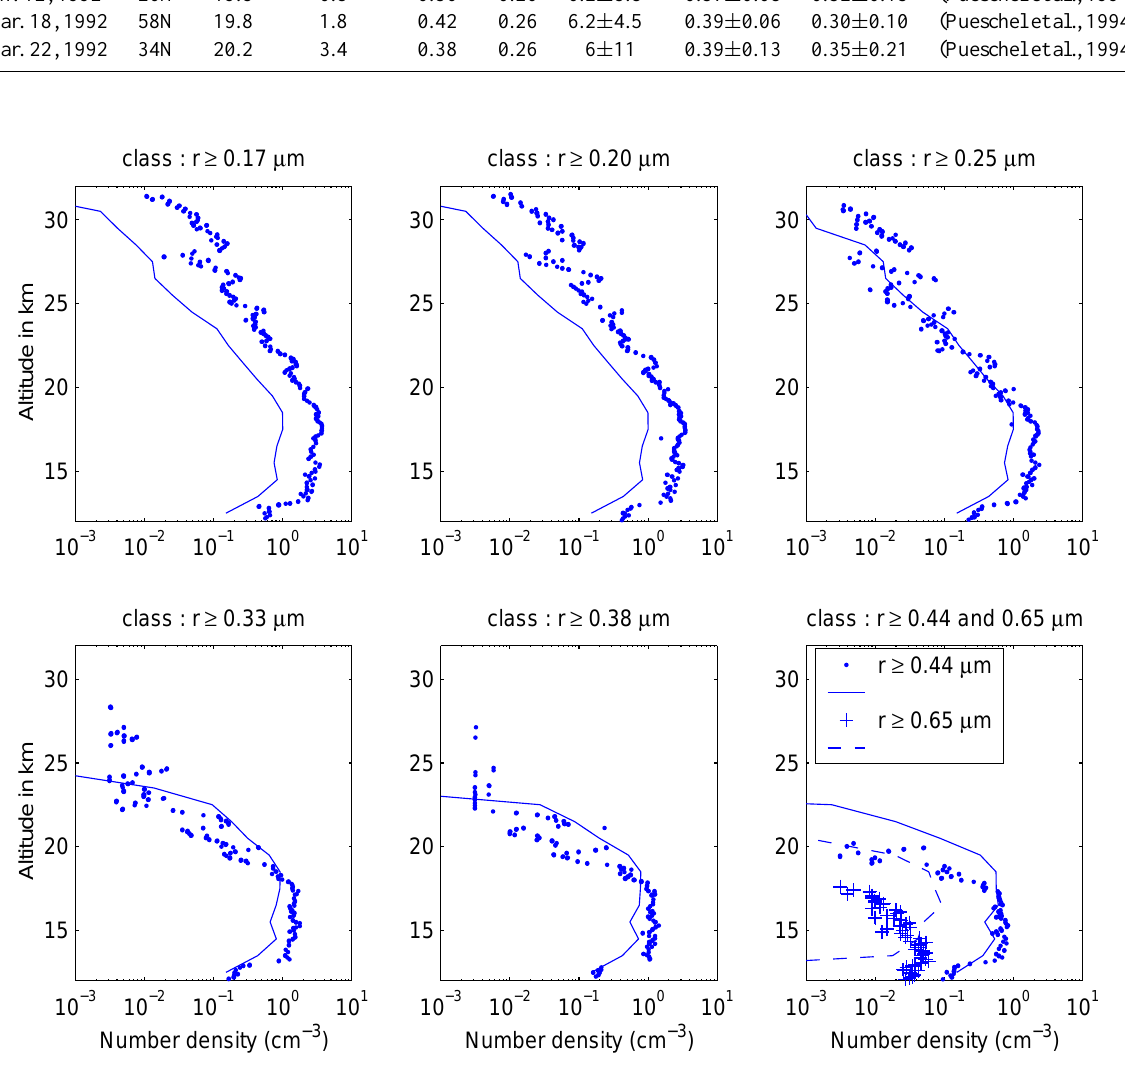
Fig. 4. Comparison of partial number densities for aerosol profiles obtained from this work (solid lines) and in situ measurements published by Sugita et al. (1999) (dots) and carried out on 29 September 1993 over Aire sur l’Adour. The particle classes take into account all the aerosol particles with radii larger than respectively 0.17, 0.20, 0.25, 0.33, 0.38, 0.44 and 0.65 µ